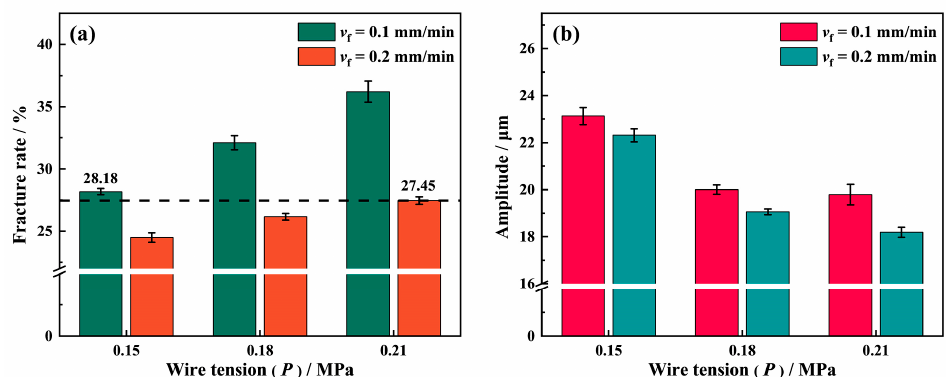
Figure 17. ( a ) Effect of wire tension ( P ) on the number of fracture chipping pits; ( b ) the amplitude of the wire vibration at v s = 1.8 m/s, v f = 0.1 mm/min and v f = 0.2 mm/min.